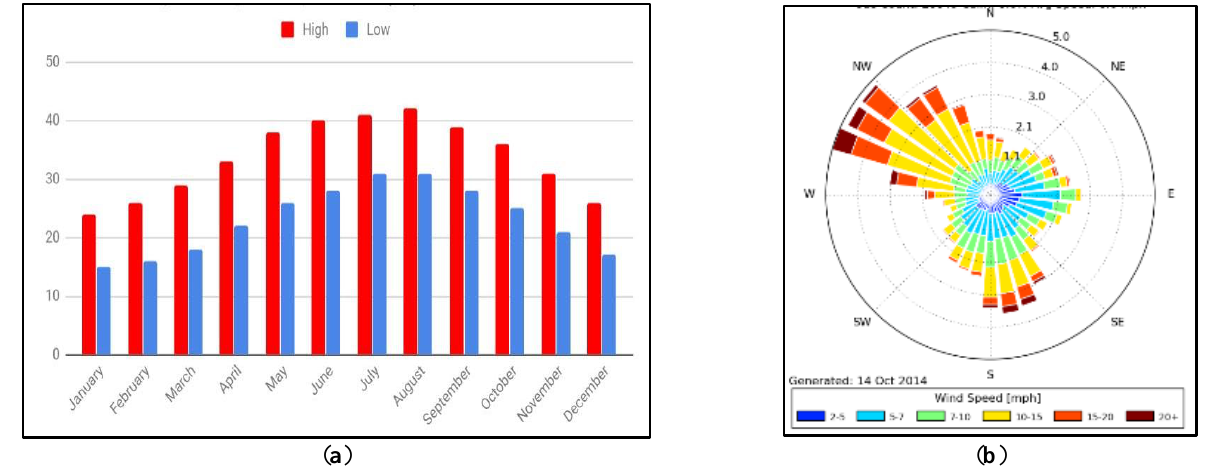
Figure 3. Climate conditions in the UAE. ( a ) — Average air temperature [44]. ( b ) — Wind rose [45].